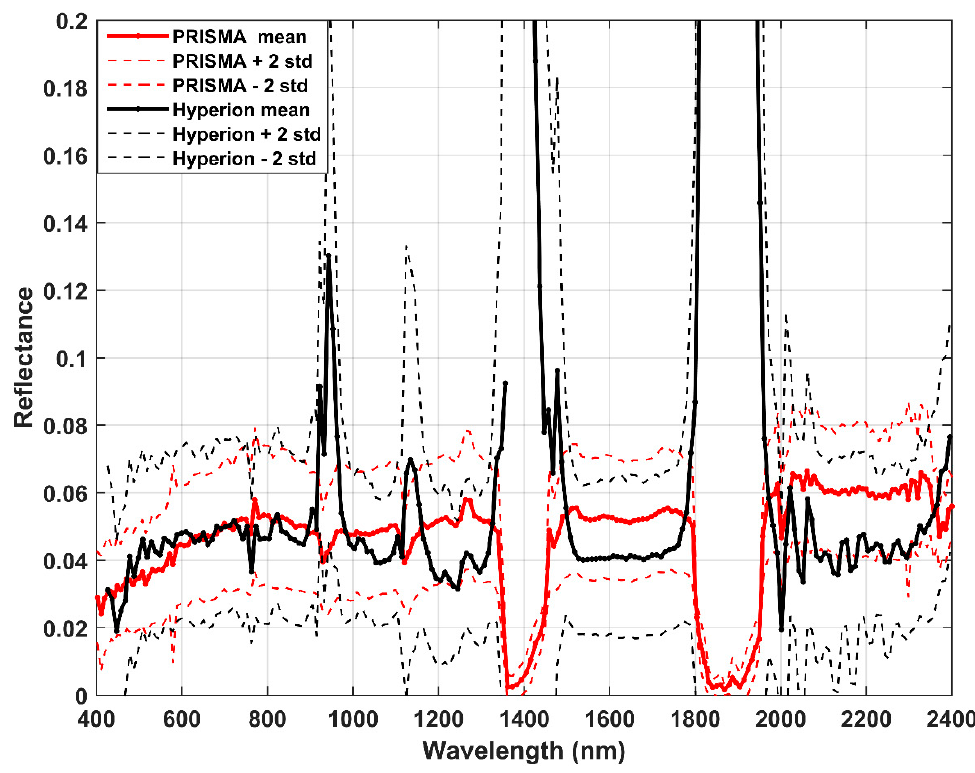
Figure 7. Profiles of PRISMA (red) and Hyperion (black).